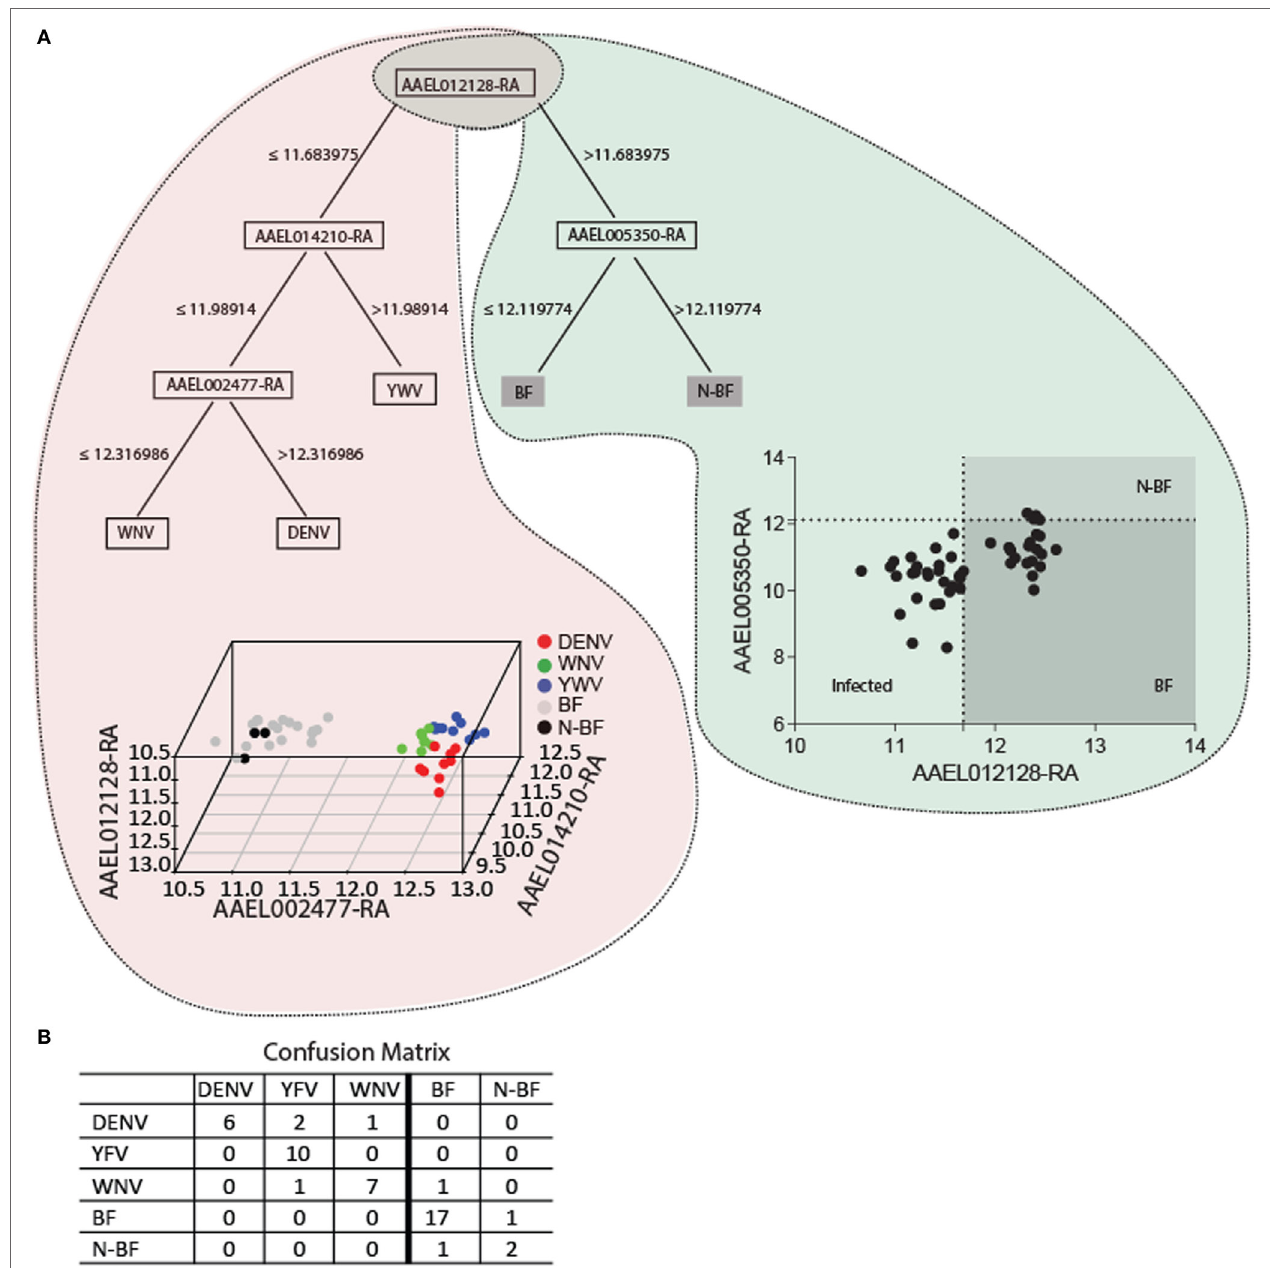
FigUre 7 | The key genes for trait classification resulting from data mining of differentially expressed genes in the modules intersection. (a) The J48 algorithm was used to build a decision tree using default parameters summarizes 110 genes of the intersection into four informative genes. The scatter-plot depicts by a cutoff the samples distribution discriminating each group. In the 3D plot samples are discriminated by colors according to the expression of the four genes. (B) The confusion matrix of the classification of the four genes estimates the classification accuracy of the decision tree. A 10-fold cross validation was